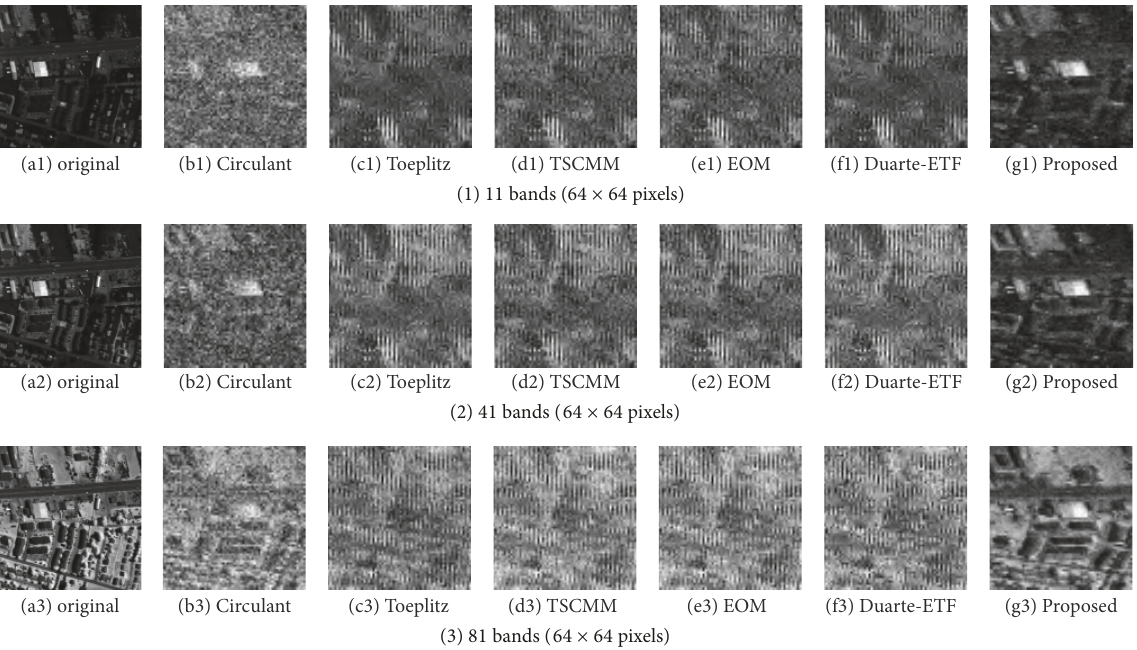
Figure 6: The subjective quality of different CS measurement matrices, from left to right: (a) original, (b) Circulant, (c) Toeplitz, (d) TSCMM, (e) EOM, (f) Duarte-ETF, and (g) proposed